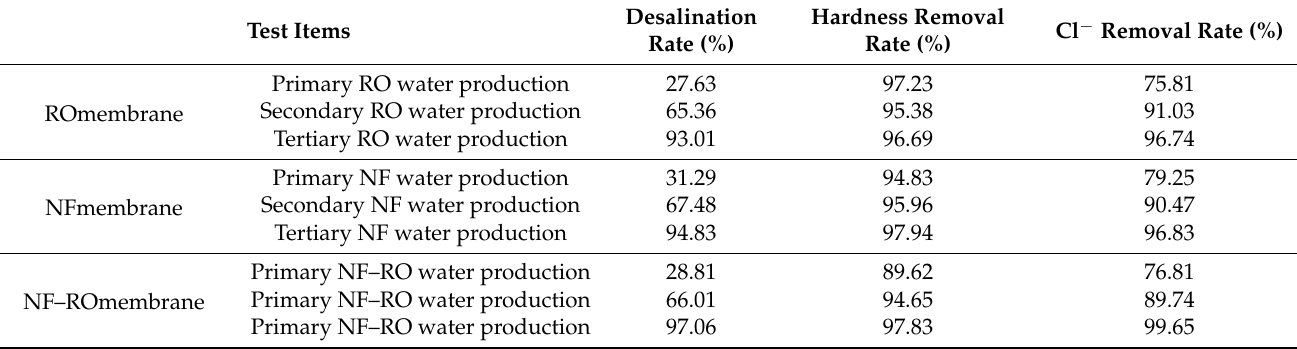
Table 3. Filtration effects of the nanofiltration and reverse osmosis